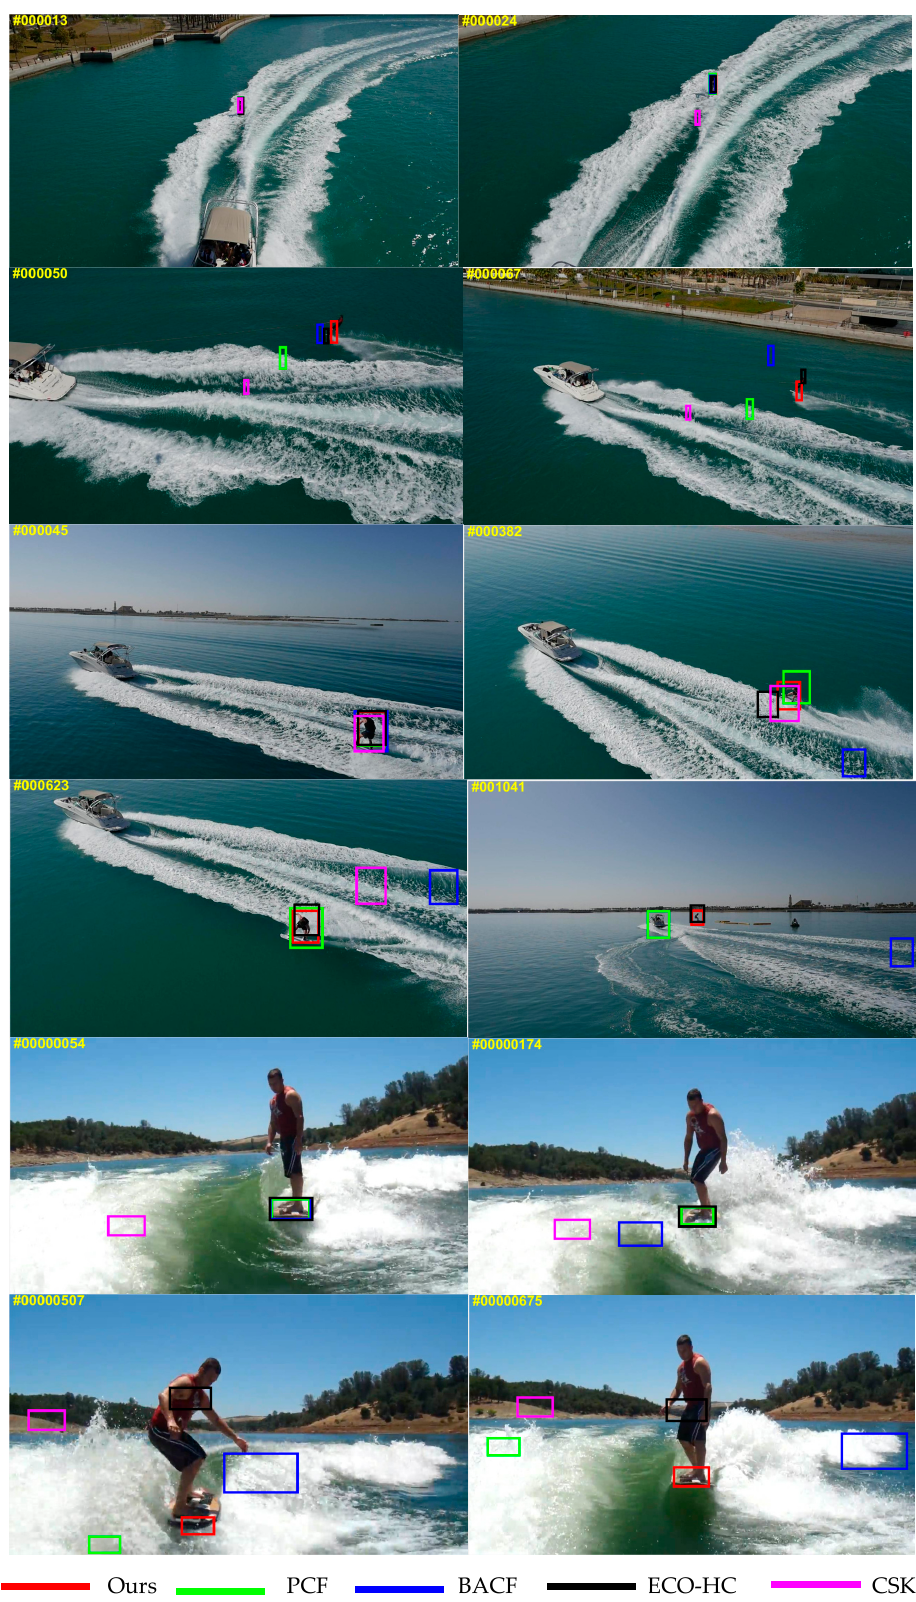
Figure 3. Qualitative experimental results from marine environmental videos. Five different colors represent representative five trackers, respectively.